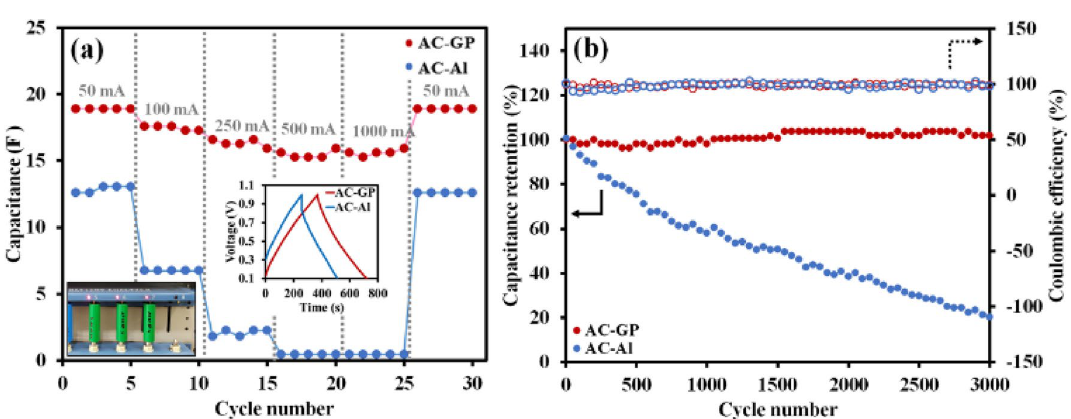
Figure 6. ( a ) Rate capability of the 18,650 cylindrical cells of AC-GP and AC-Al, and ( b ) stability at 100